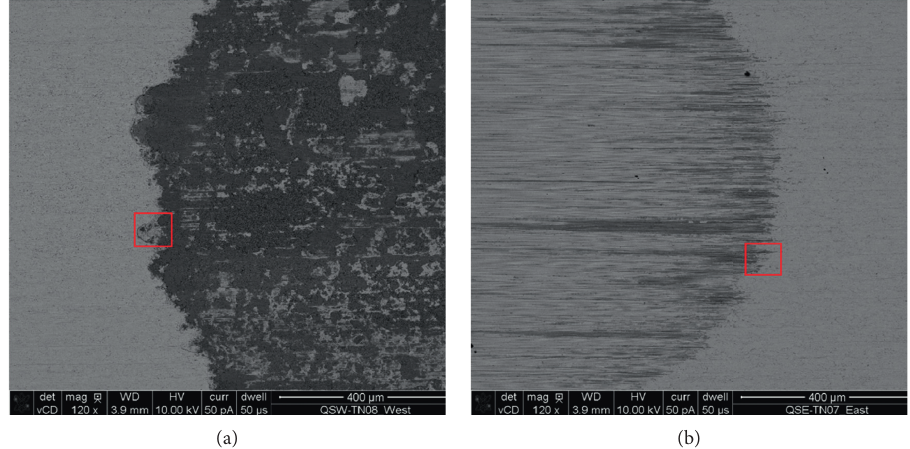
Figure 6: SEM overview of experiments: (a) TN08 (water). (b) TN07 (brine).